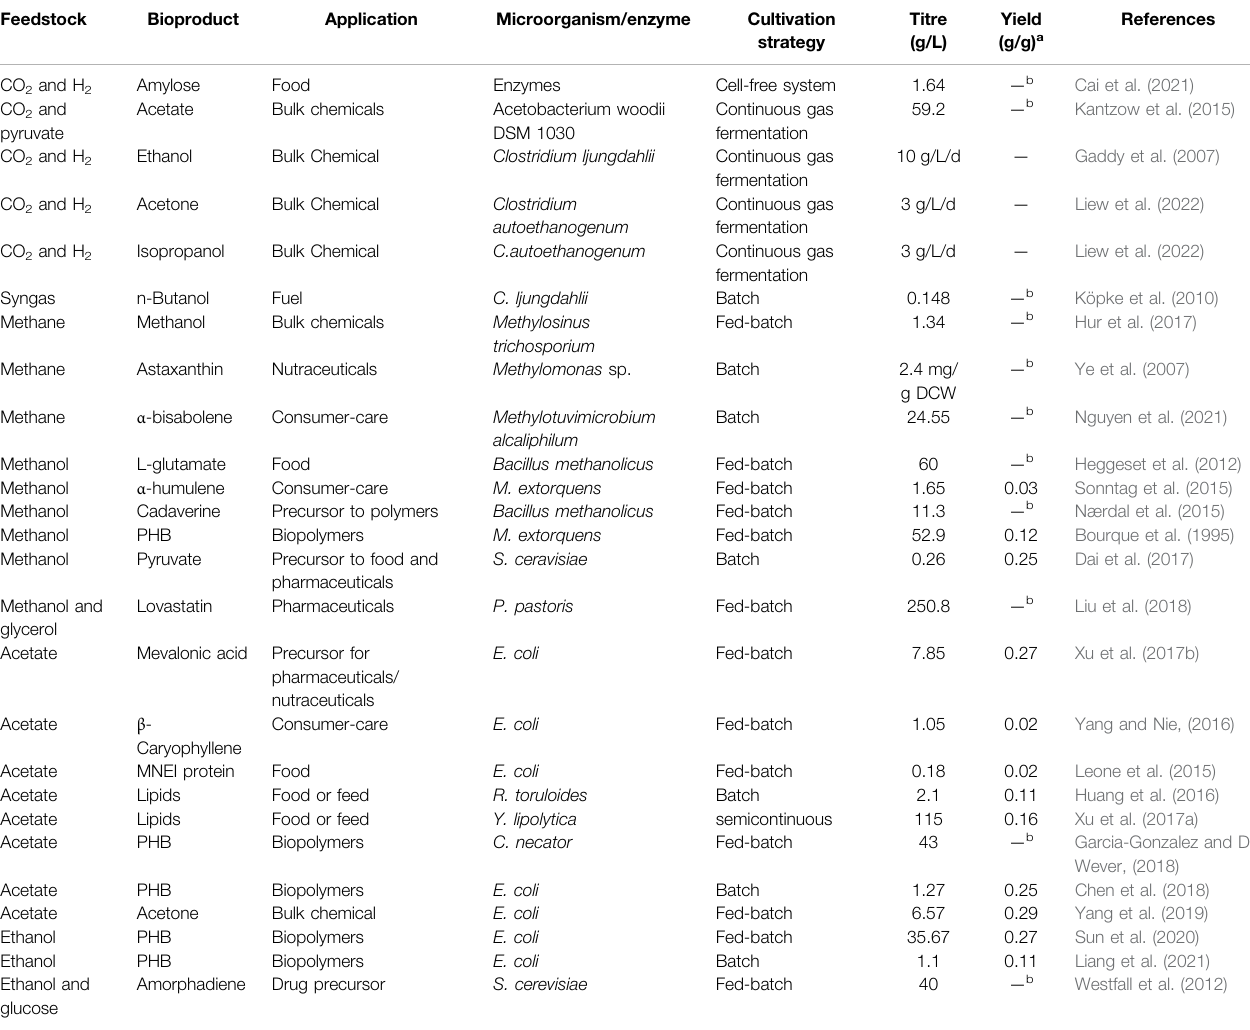
TABLE 2 | Bioproducts derived from C1 and C2 feedstocks using microbes and enzymatic reactions.